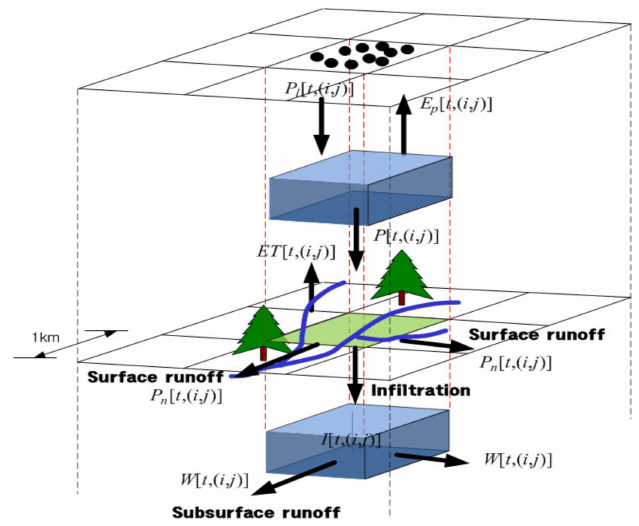
Figure 3. Grid type water balance calculation concept diagram